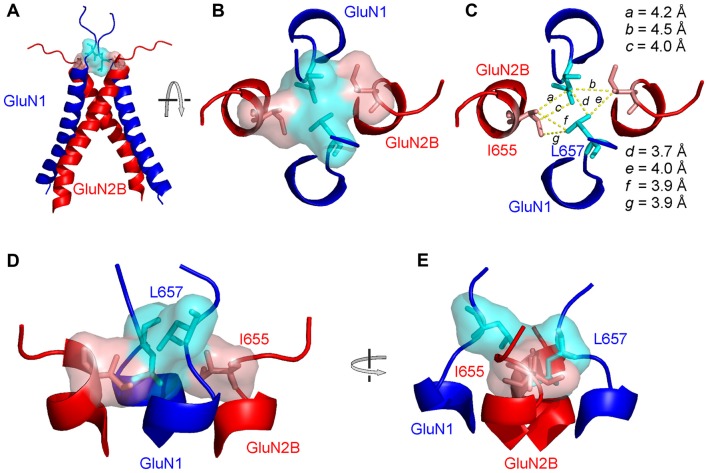
The structural arrangement of the NMDAR channel gate. (A) Ribbon diagram showing the GluN1 (blue) and GluN2B (red) M3 helices with the initial portion of the M3-S2 linkers. Semitransparent molecular surface representation of GluN1 L657 and GluN2B I655 is indicated in light blue and light red, respectively. (B) The extracellular channel gate of the GluN1/GluN2B receptor is shown in a closed conformation and viewed from the extracellular side of the membrane. (C) The same view is shown with molecular distances between L657 and I655 residues indicated. (D,E) The structure of the gate viewed from the side with the GluN1 M3 helices in the front and in the back (D) and rotated by 90° along the longitudinal axis (E).